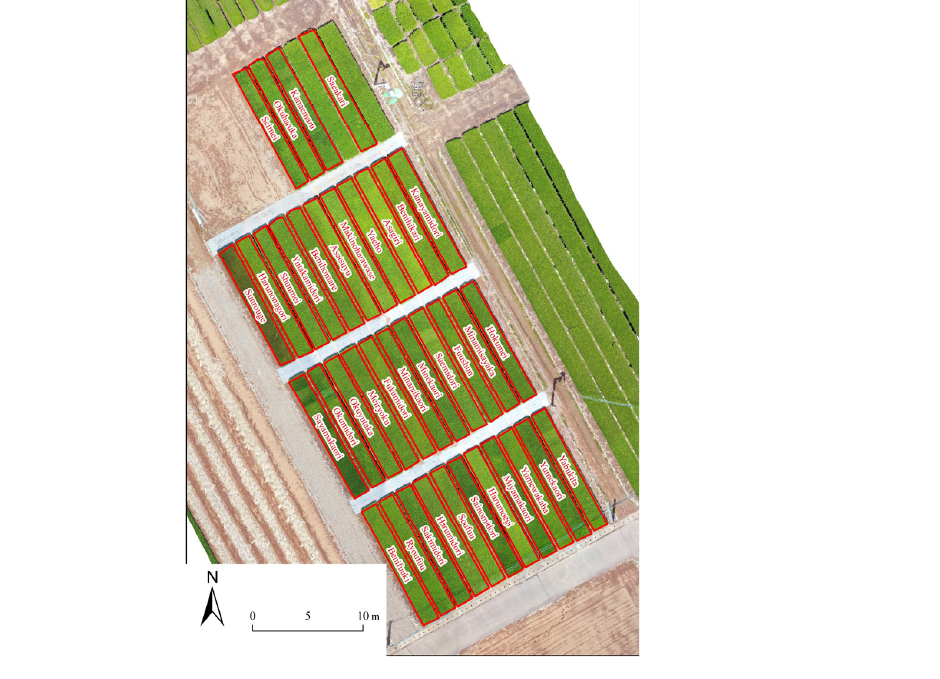
Figure 1. Aerial view of the tea field sampled in this study.